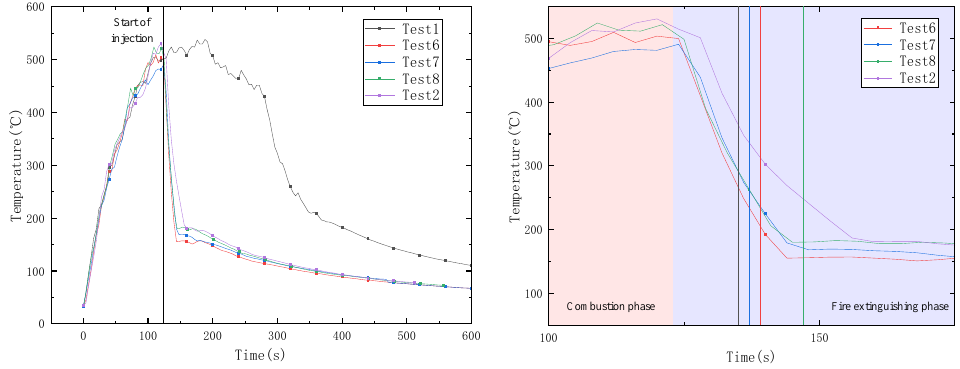
Figure 8. Temperatures above the fire source under different conditions.